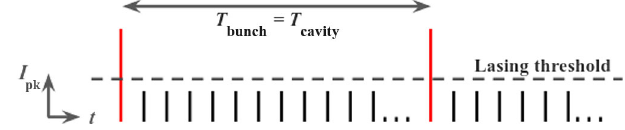
FIG. 11. Proposed bunch train structure for ring-FEL coupling. Each vertical line represents one bunch, with its height propor- tional to peak current I and thus TGU gain by Eq. (13). Tall red pk exceed- bunches are the designated “ XFELO bunches ” with I pk ing the lasing threshold set by single-turn cavity loss. The temporal gap between XFELO bunches T is equal to the bunch x-ray round-trip time T . The non-XFELO bunches (black) cavity lay below the lasing threshold and only experience spontaneous undulator radiation. Thus, they are able to avoid substantial emittance degradation from the XFELO lasing